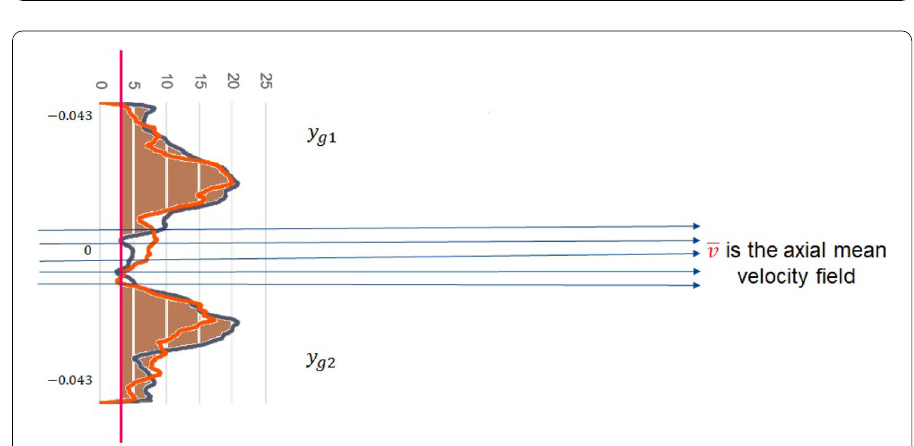
Fig. 59 Illustration of the positions of the two recircluation zones on each wall